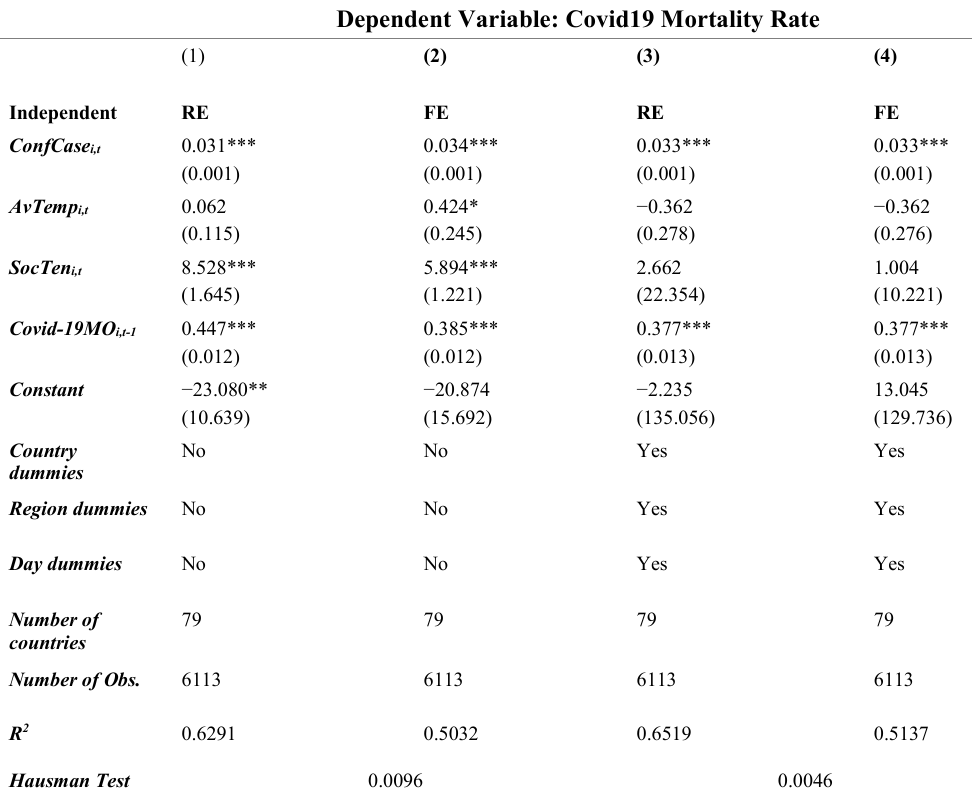
Table 2. Global Panel Fixed and Random Effect Results Dependent Variable: Covid19 Mortality